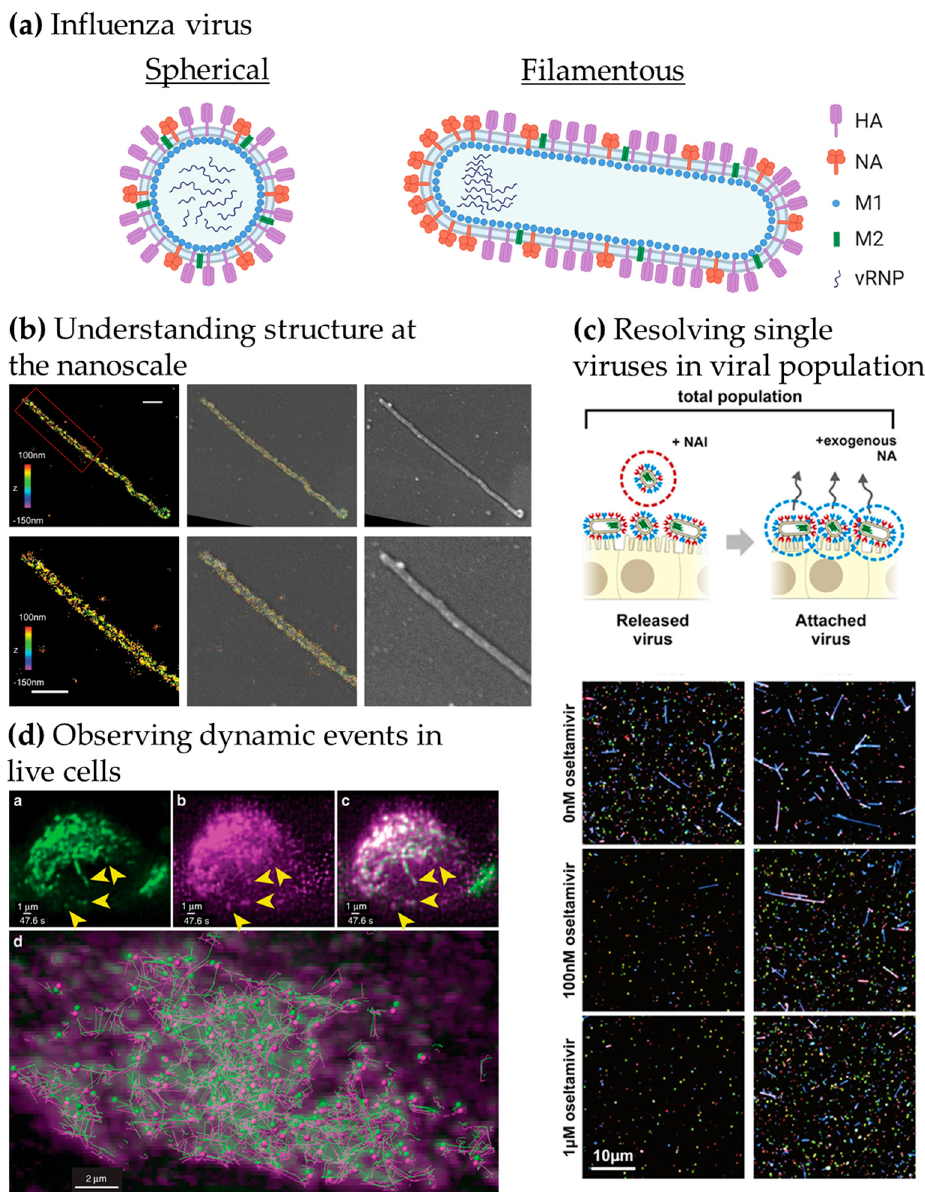
Figure 1. Advanced microscopy gives structural and functional insights into influenza virus repli ‐ cation. ( a ) Structure of influenza virions. Spherical particles diameter ~120 nm; filamentous parti ‐ cles length up to 20 μ m [8,9]. ( b ) Understanding viral structure at the nanoscale. Correlative 3D ‐ STORM and scanning electron microscopy (SEM) images of filamentous Udorn influenza virus immuno ‐ labelled for HA. Left: STORM image. Right: SEM image. Middle: Overlaid image. Bot ‐ tom: Magnified views of the region of interest shown on top. Scale bars: 500 nm. Adapted from [19]. ( c ) Resolving single viruses in viral populations. Influenza ‐ infected cells were treated with oseltamivir, a neuraminidase inhibitor at different concentrations and the “Released” viruses and the viruses that remained “Attached” were imaged. Adapted from [22]. ( d ) Observing dynamic events in live cells. Live ‐ cell light ‐ sheet three ‐ dimensional (3D) imaging of cells expressing GFP ‐ Rab11A were infected with recombinant influenza expressing mRuby ‐ PA as a marker for the vRNP. Top, left to right: GFP ‐ Rab11A, mRuby ‐ PA, overlay (arrows: colocalizing puncta). Bottom: colocalizing puncta of GFP ‐ Rab11A and mRuby ‐ PA tracks over time. Adapted from [24].